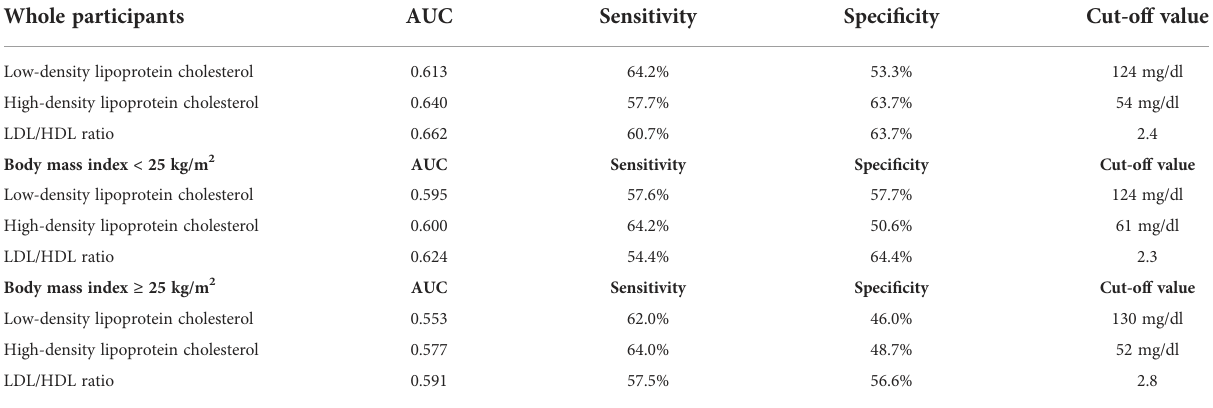
TABLE 3 The area under the curve and optimal cut-off